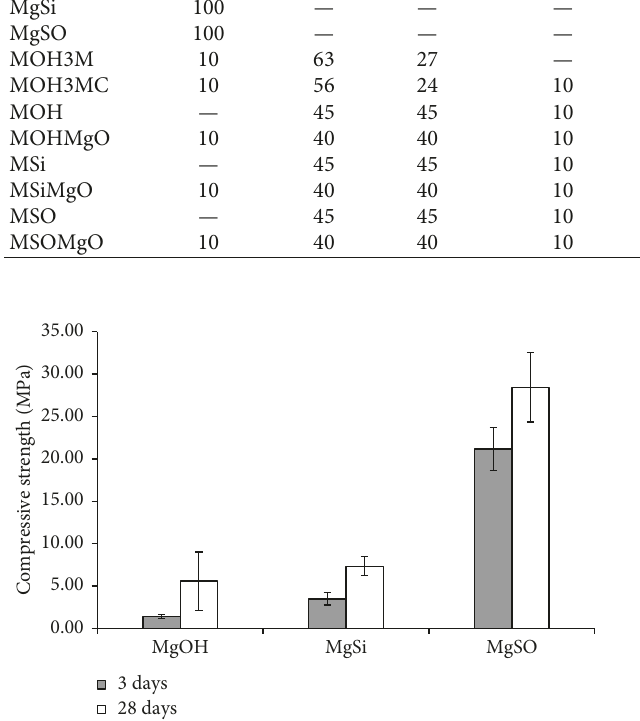
Figure 2: Effects of alkali activator type on the strength devel- opment of magnesia pastes.